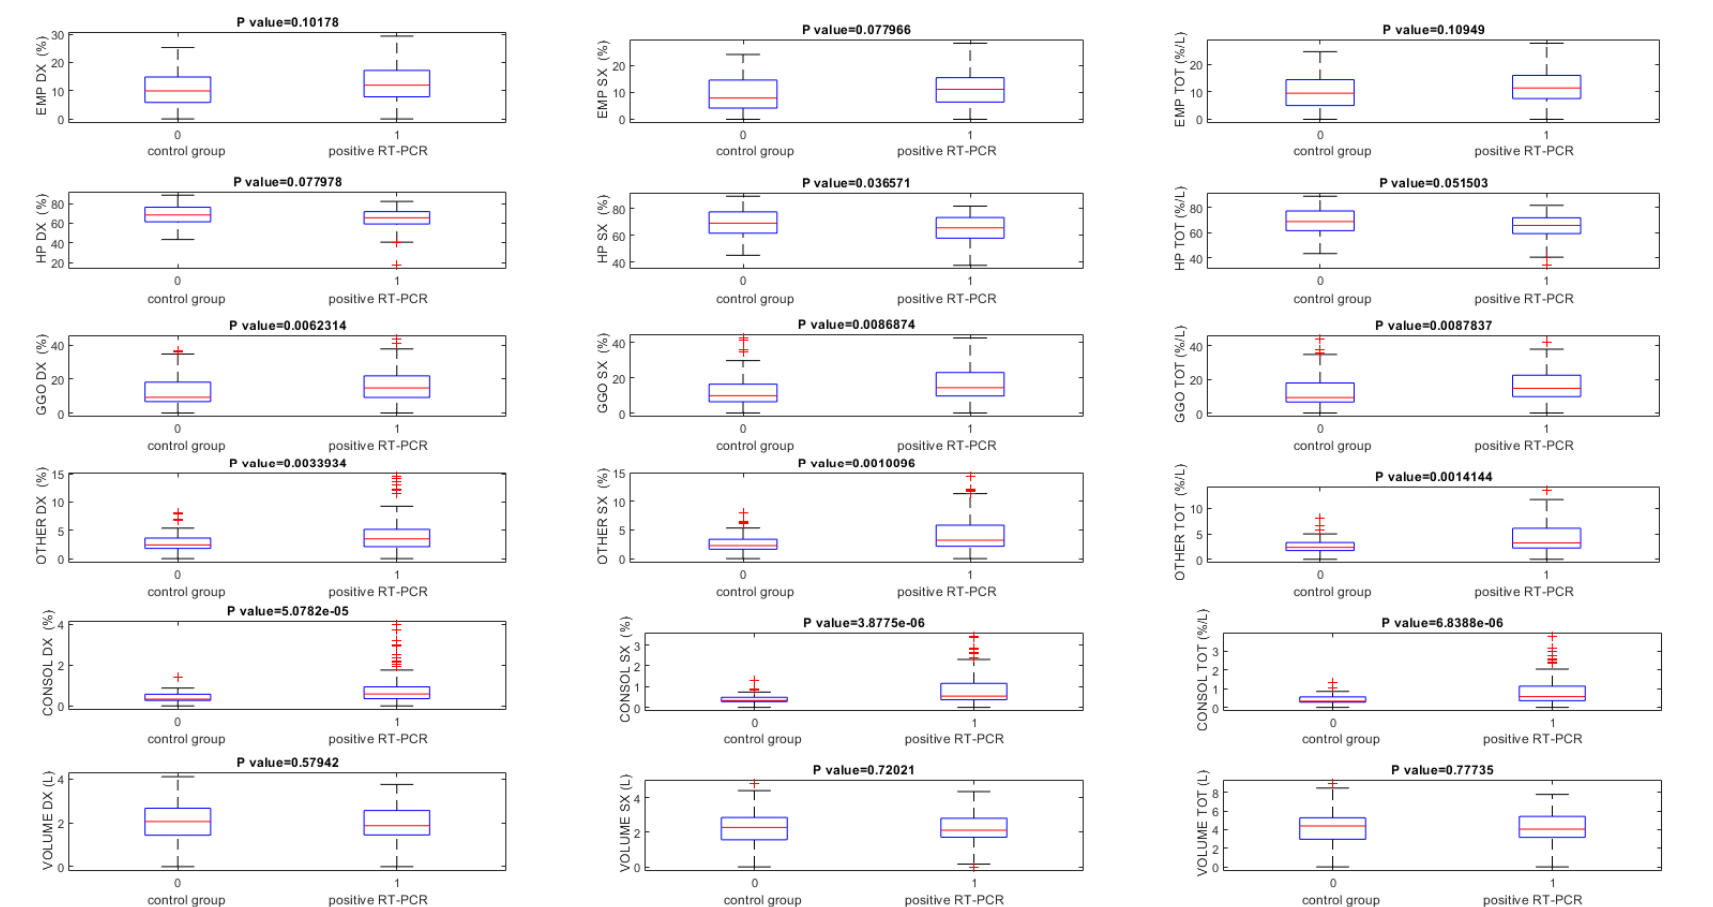
Figure 4. Boxplot of lung volumes quantified using the ANKE ASG-340 CT workstation pneumonia tool obtained on baseline CT scans. Note. EMP = emphysema; HP = health parenchyma; GGO = ground-glass opacity; CONSOL = consolidations.